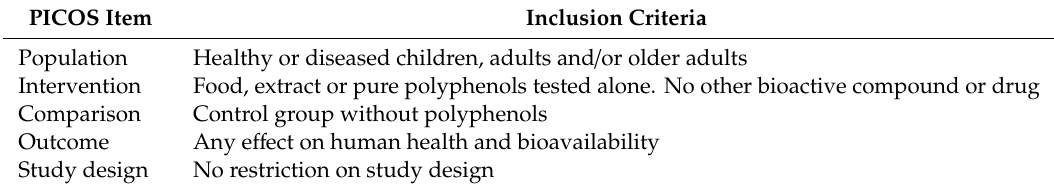
Table 1. Population, Intervention, Comparison, Outcome, Study design (PICOS) criteria for trial selection